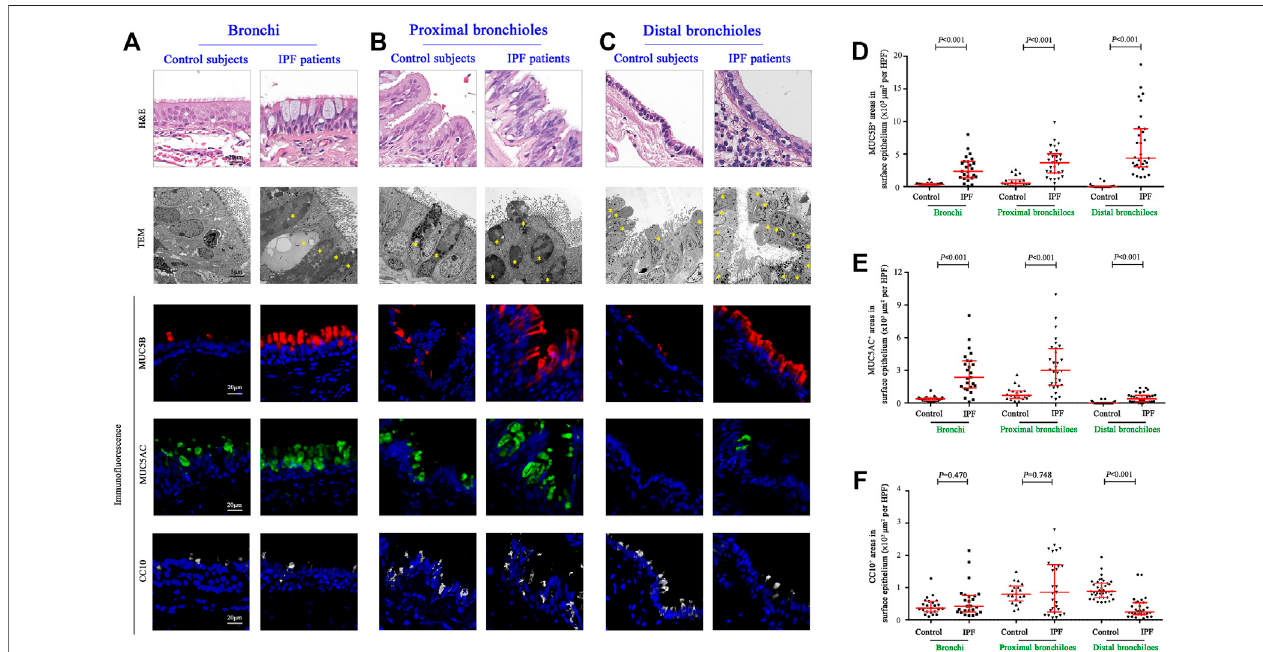
FIGURE 2 | Morphology and expression of secretory proteins in the surface epithelium of the conducting airways. Representative images of H&E staining, TEM, and IF staining showing the morphology and immunopositive secretory cells (A – C) ; H&E staining and TEM revealed hyperplasia of secretory cells in the epithelium of bronchi and proximal and distal bronchioles from IPF patients, respectively. Quantitation of positive expression areas of MUC5B (red), MUC5AC (green), and CC10 (white)indifferentairwaycompartmentsbetweencontrolsubjectsandIPFpatients (D – F) .DAPIlabelingofnuclei(blue).CC10,clubcell10 kDaprotein;DAPI,4 ′ ,6- diamidino-2-phenylindole; IF, immuno fl uorescence; IPF, idiopathic pulmonary fi brosis; MUC5AC, mucin 5AC; MUC5B, mucin 5B; TEM, transmission electron microscope; ns, not signi fi